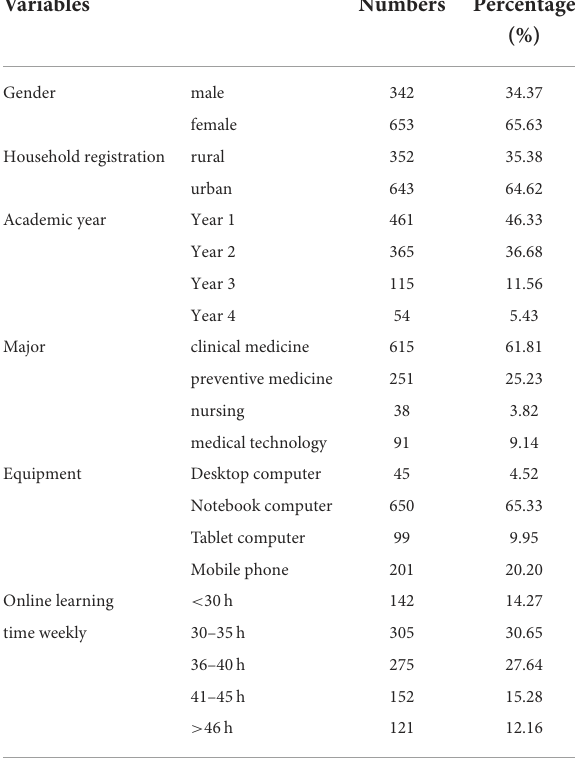
TABLE 1 Demographic characteristic of